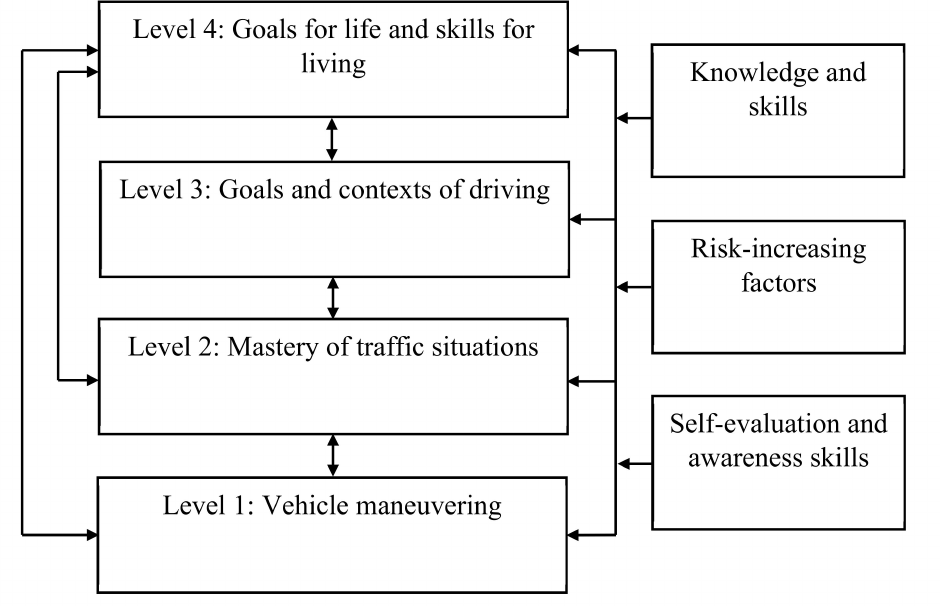
Figure 1. The Goals for Driver Education (adapted from Hatakka et al.